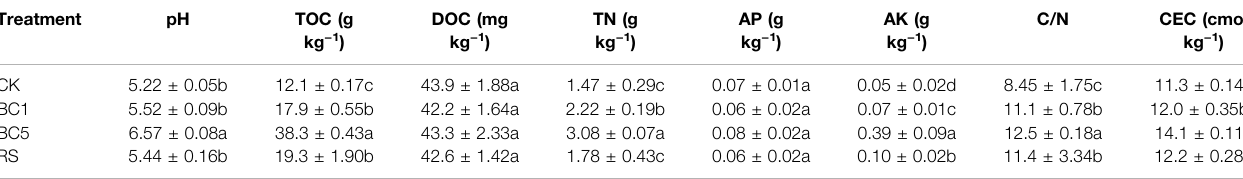
TABLE 1 | Effects of different treatments on soil properties. Treatment